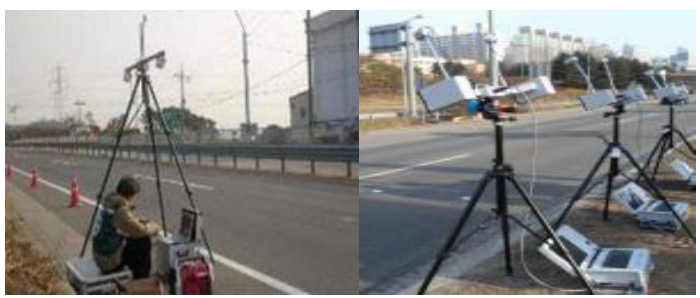
Figure 1. Vehicle velocity measurement with existing equipment.